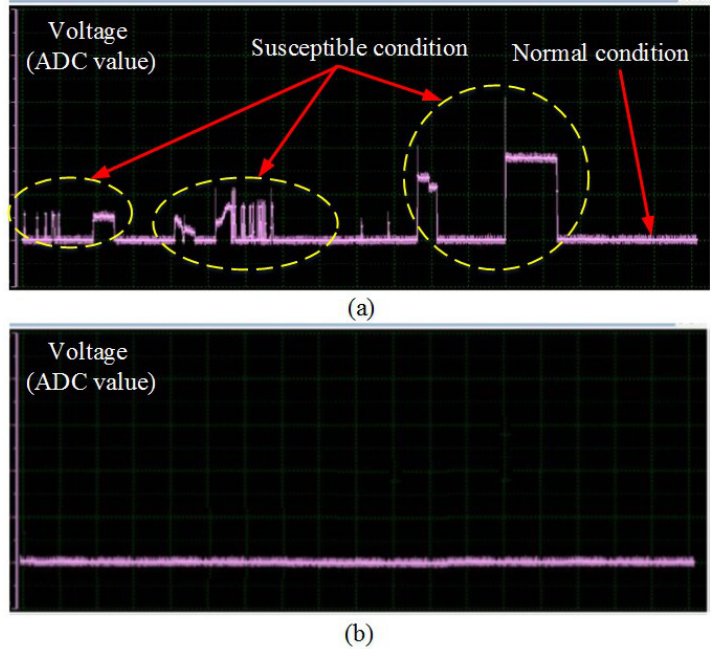
Figure 18. Performed NFIT RI results for a specific automotive industry electronic DUT with H-field probe (see Figure 16b): ( a ) Induced voltage in PCB with near-field H-field probe driven by 15 W input power (error debugging); and ( b ) Induced voltage in PCB after circuit modification (error rectification) with H-field probe driven by same 15 W input